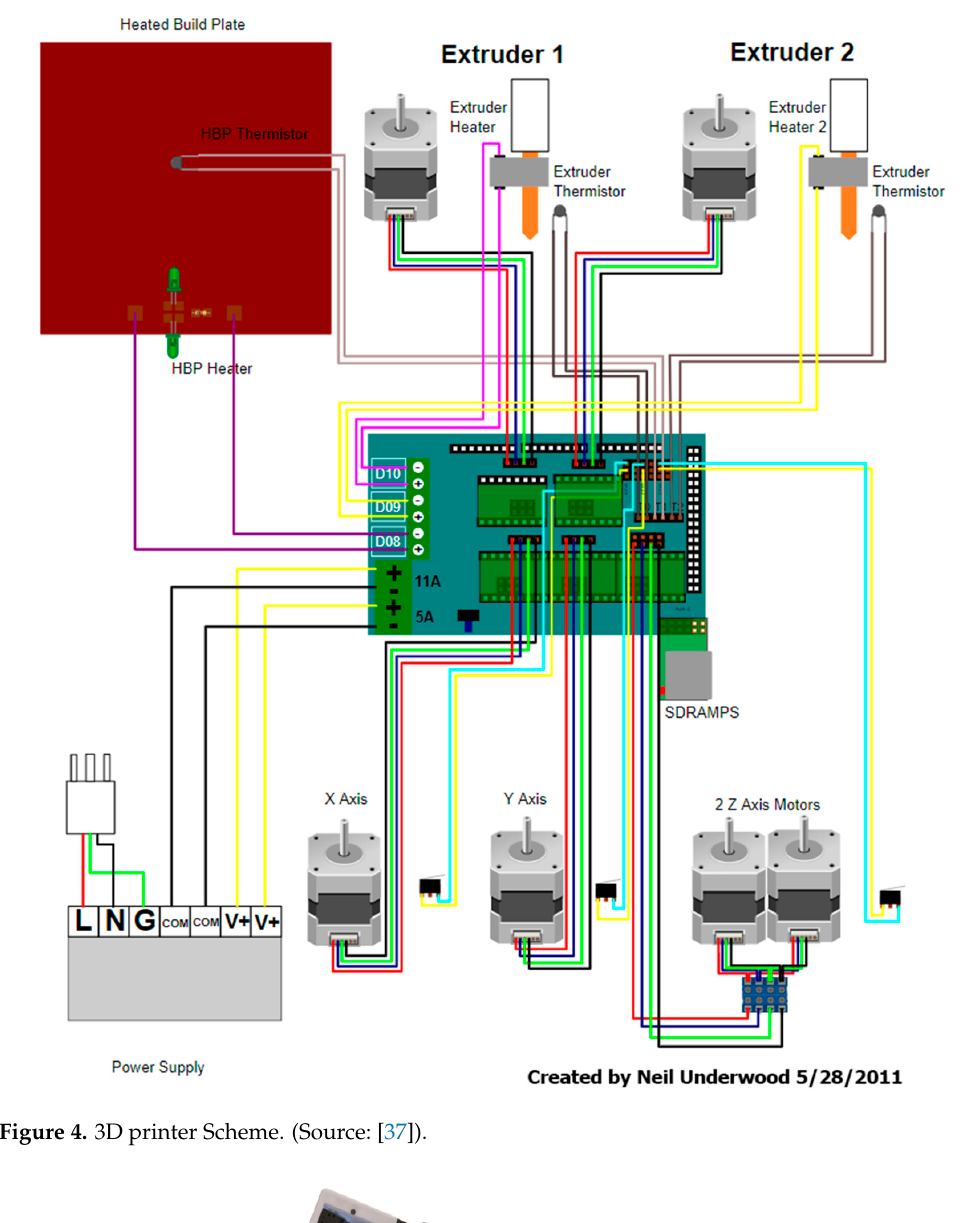
Figure 4. 3D printer Scheme. (Source: [37]).